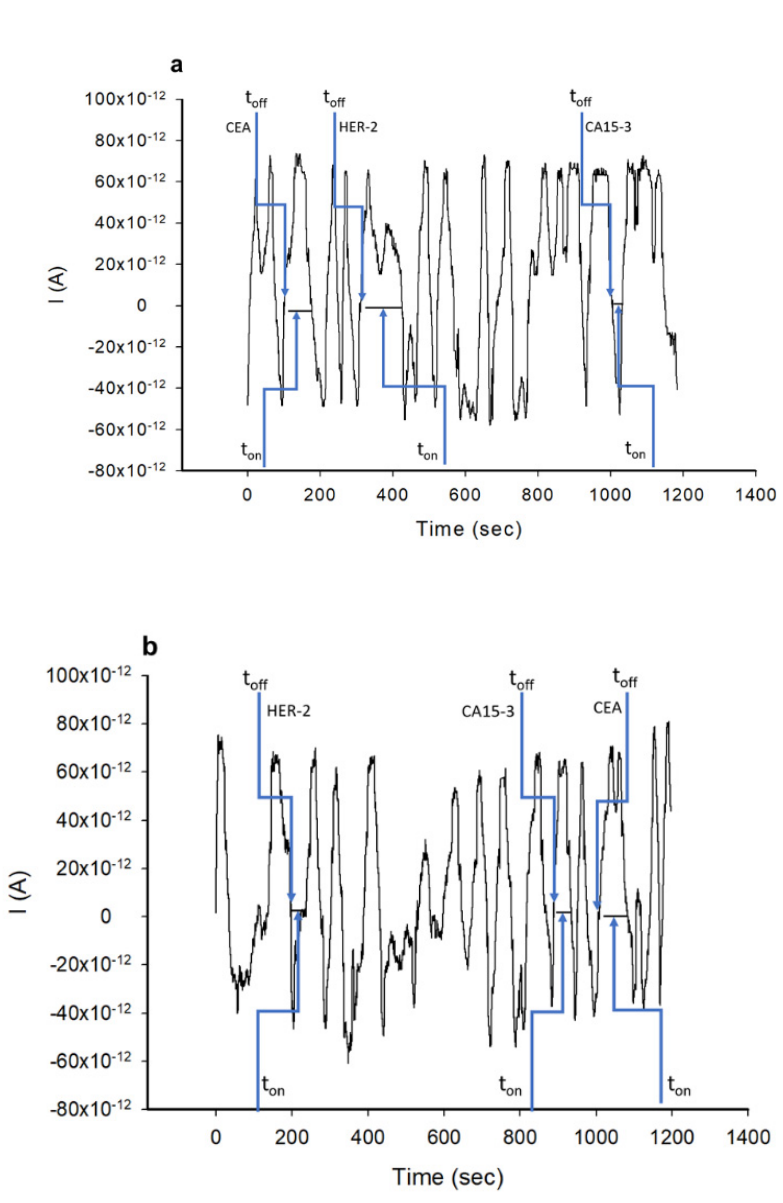
Figure 1. Pattern recognition of CA15-3, CEA and HER2 in whole blood samples, using stochastic microsensors based on ( a ) Fe(TPFPP)Cl/AuNp and ( b ) TPP/AuNp.